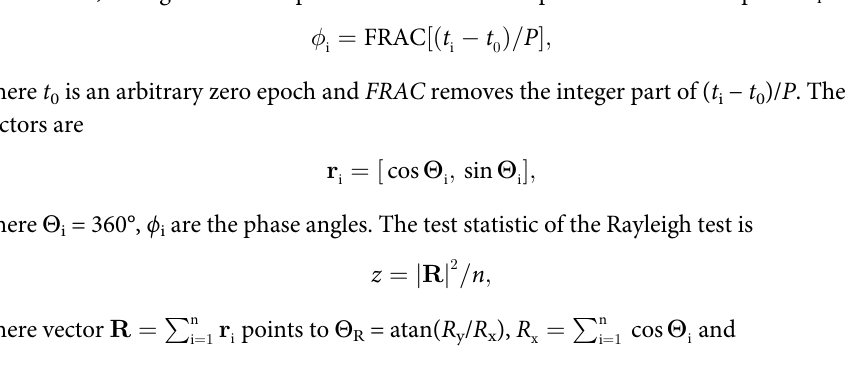
The day ( D ) and month ( M ) values in CC used in computing the time points ( t i ) for the days with